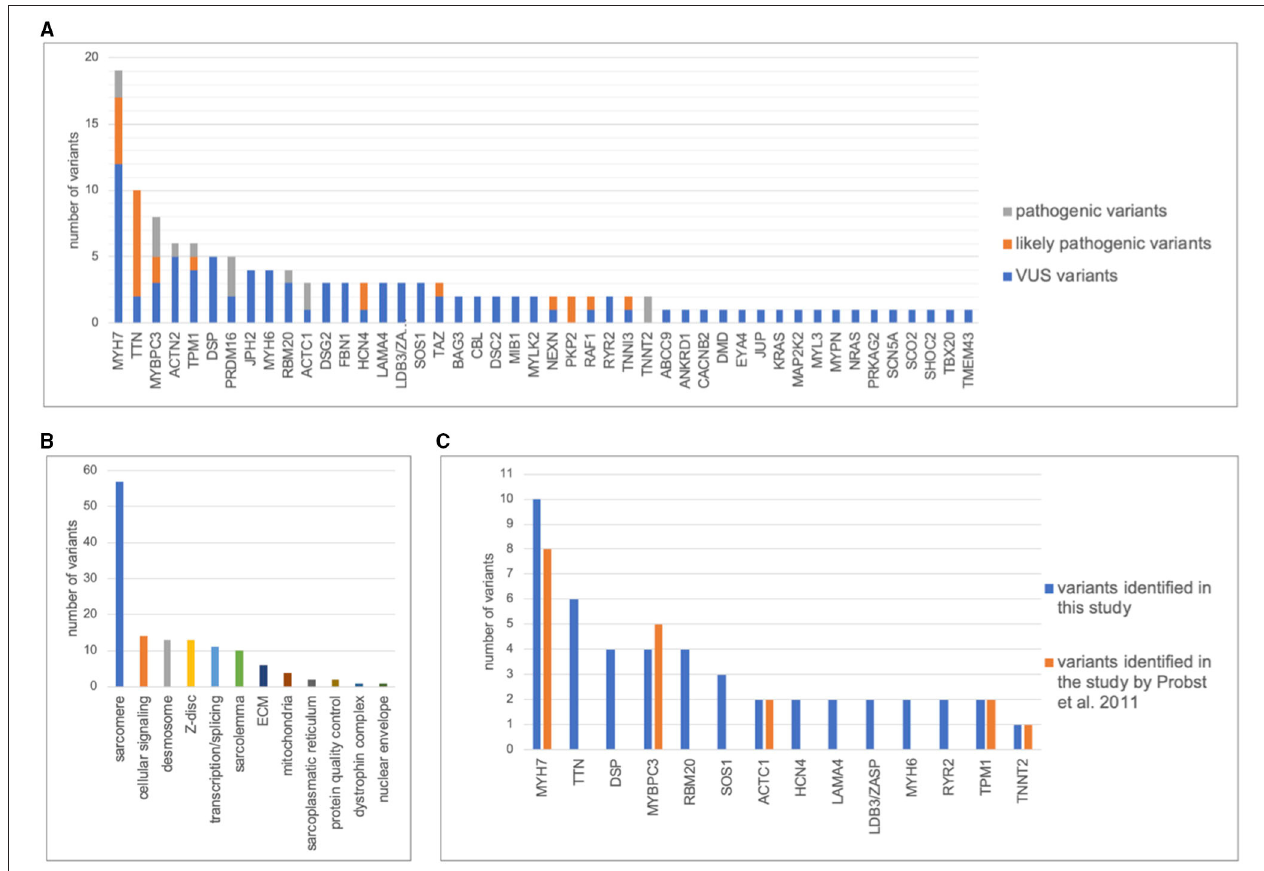
FIGURE 2 | Distribution of genetic variants. Distribution of variants in cardiomyopathy genes including pathogenic, likely pathogenic, and variants of unknown significance (VUS). The figure only contains the most frequent genes. (A) , Number of variants detected per gene. (B) , Distribution of variants between functional groups. (C) , Number of variants found in 63 index patients by Sanger sequencing of 8 cardiomyopathy genes by Probst et al., 2011 ( 26) compared with next generation sequencing of 89 cardiomyopathy genes in this